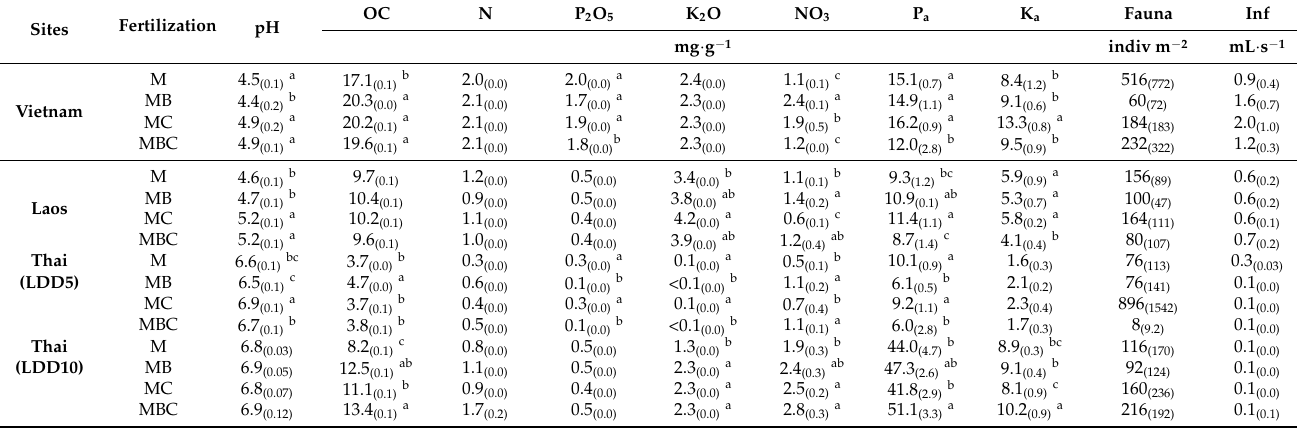
Table 3. Effect of compost and biochar on soil chemical, physical and biological properties, of soil samples collected after maize harvest. Treatments are represented as follow: (M) NPK fertilizer only, (MB) NPK + biochar; (MC) NPK + compost and (MBC) NPK + compost and biochar. Variables are: pH H2O , OC, N, NO 3 − , K and P total (P 2 O 5 , K 2 O), available K and P (P a and K a ), macrofauna abundance (Fauna), and infiltration rate of water (Inf). Different letters indicate significant differences among treatments of the same